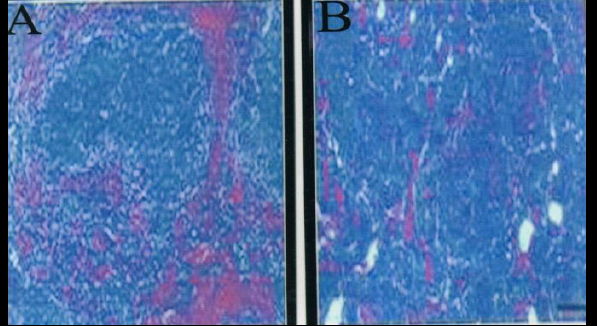
Figure 4 sections of spleen Ecoli – infected rat Extensive leukocyte infiltration after infected rat compared with normal control spleen tissue (A) Leukocytes disappeared from white pulp and infiltrated the red pulp (B) Hematoxylin -eosin (HE)